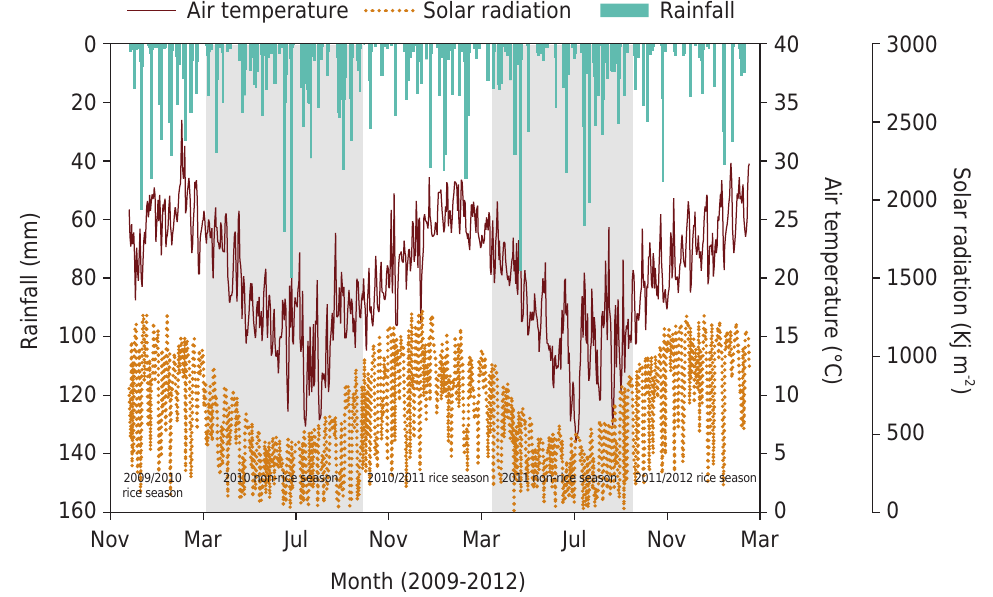
Figure 1. Rainfall, air temperature, and solar radiation during the period